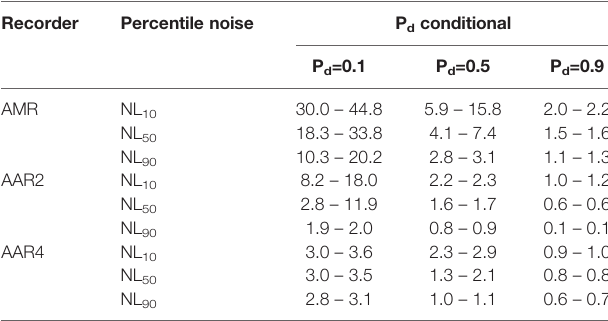
TABLE 3 | Detection ranges (km) of male humpback whale vocalizations in May around AAR2, AAR4 and AMR.